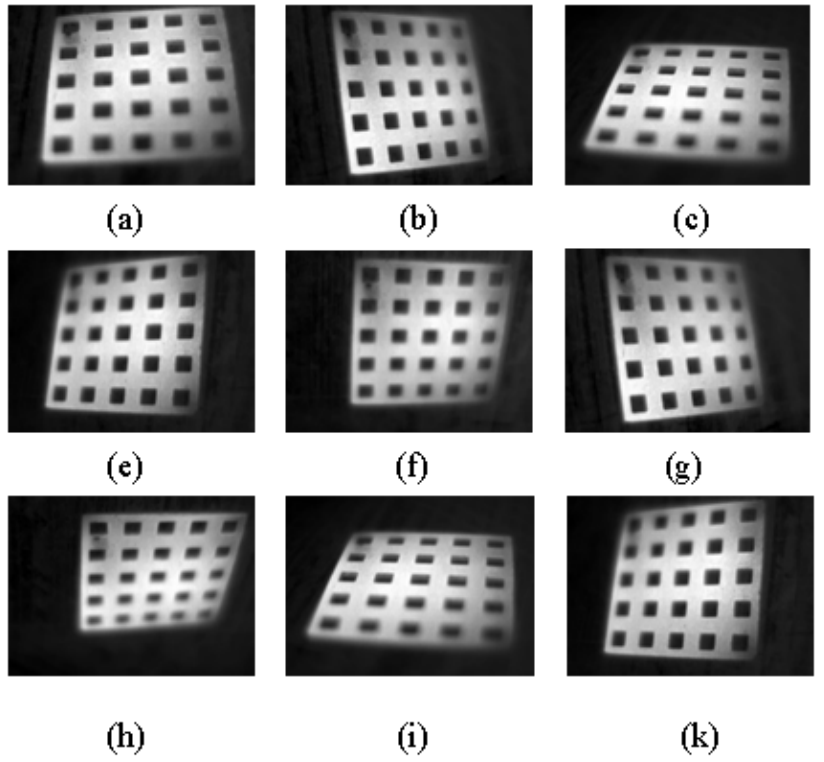
Figure 9. Calibration images based on the method of using hollow calibration targets. ( a – k ) are images captured from different views. Table 3. Comparison of measurement results.